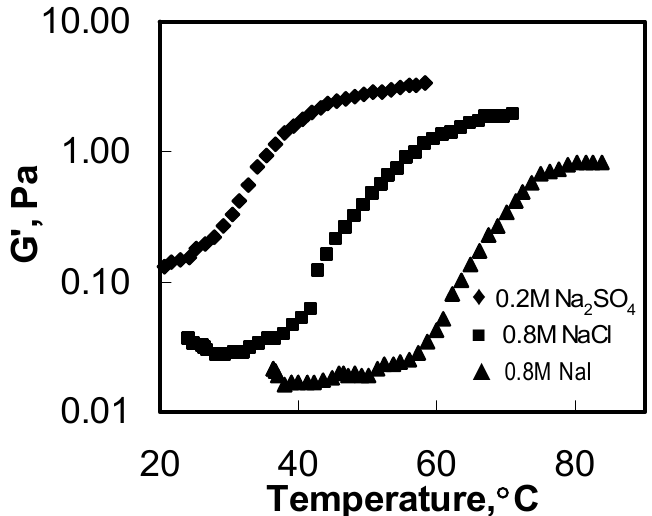
Figure 6. G  as a function of temperature for the aqueous solution of 1 wt% HPMC with various salt additives measured during heating process (frequency = 1 rad/s, heating rate = 1